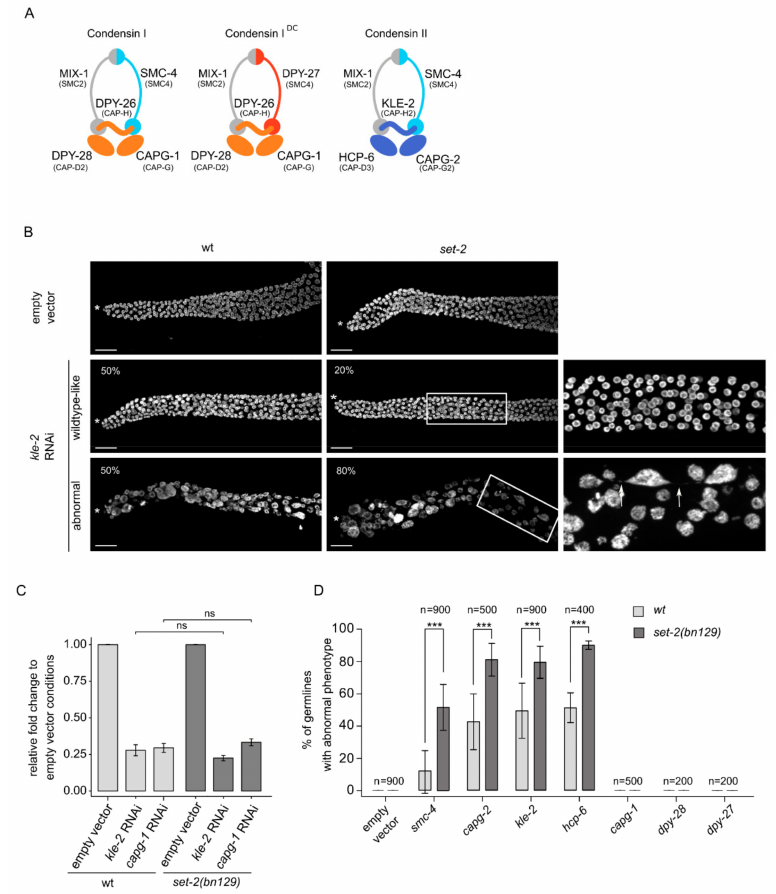
Figure 2. set-2 inactivation enhances condensin-II depletion phenotypes. ( A ) C. elegans condensin subunits and their vertebrate homologs. ( B ) Confocal images of DAPI-stained distal germline region from wildtype and set-2(bn129) animals treated with empty vector or kle-2 RNAi. (*) marks distal end of the gonad. Representative images show examples of “wildtype-like” and “abnormal” phenotypes, with their presence indicated as percentage (%) of total (n = 900, from 9 independent biological replicates) (scale bar, 20 µ m). Arrow indicates the presence of chromatin bridge (scale bar, 10 µ m). Images correspond to a Max intensity projection using using Fiji. ( C ) kle-2 and capg-1 mRNA levels in wildtype and set-2(bn129) mutant animals after RNAi directed against the respective genes. Relative fold change was calculated with respect to empty vector condition, following normalization with pmp-3 and cdc-42 . [*] p < 0.05 t -test. ( D ) Percentage of germlines with “abnormal” phenotype after RNAi directed against condensin-II ( smc-4 , capg-2 , kle-2 and hcp-6 ), condensins I ( capg-1 , dpy-28 ) and condensin I DC ( dpy-27 ) in wildtype or set-2(bn129) mutants. n = number of animals scored from 9 independent experiments for smc-4 and kle-2 , 4 for hcp-6 , and 5 for capg-1 and capg-2 , and 2 for dpy-28 and dpy-27 . All scoring was performed in blind. *** p < 0.001 ( t